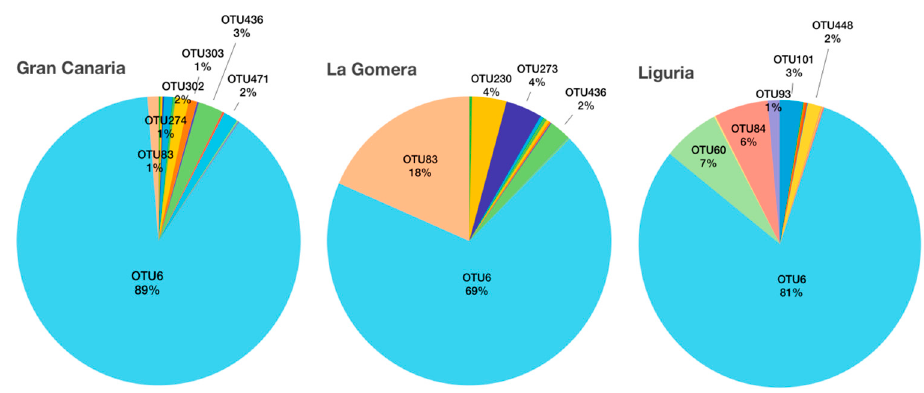
Figure 3. Average percentages of OTU abundance (read numbers) per orchid population (Gran Canaria La Gomera, Liguria-Italy).